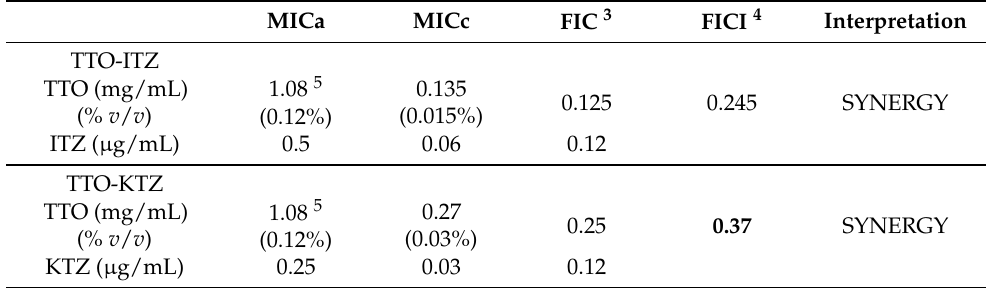
Table 3. MIC 1 and MFC 2 indexes of Tea Tree Oil (TTO) plus itraconazole (ITZ) or ketoconazole (KTZ) against Trichophyton rubrum SL 171/13